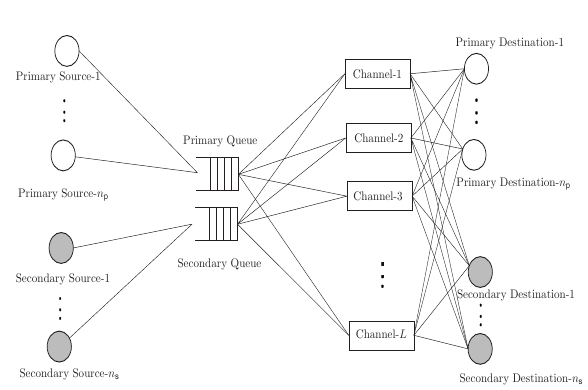
Figure 2. Traditional first come first serve queuing model for a multichannel cognitive radio network with multiple primary and secondary users.